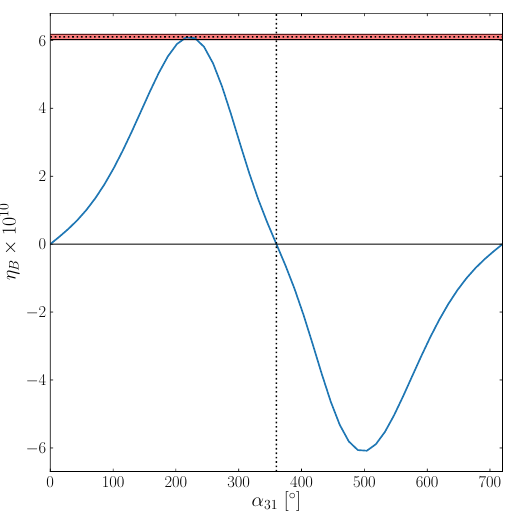
Figure 5 . The baryon asymmetry with M 1 = 5 : 13 10 10 GeV and CP violation provided solely (cid:2) by (cid:11) 31 (corresponding to (cid:14) = 0 (cid:14) , (cid:11) 21 = 180 (cid:14) ). The red band indicates the 1 (cid:27) observed values for (cid:17) B with the best-(cid:12)t value indicated by the horizontal black dotted lines. Here we show the baryon asymmetry as a function of (cid:11) 31 , exact CP -invariance exists for (cid:11) 31 = 0 (cid:14) and 360 (cid:14) (vertical black dotted